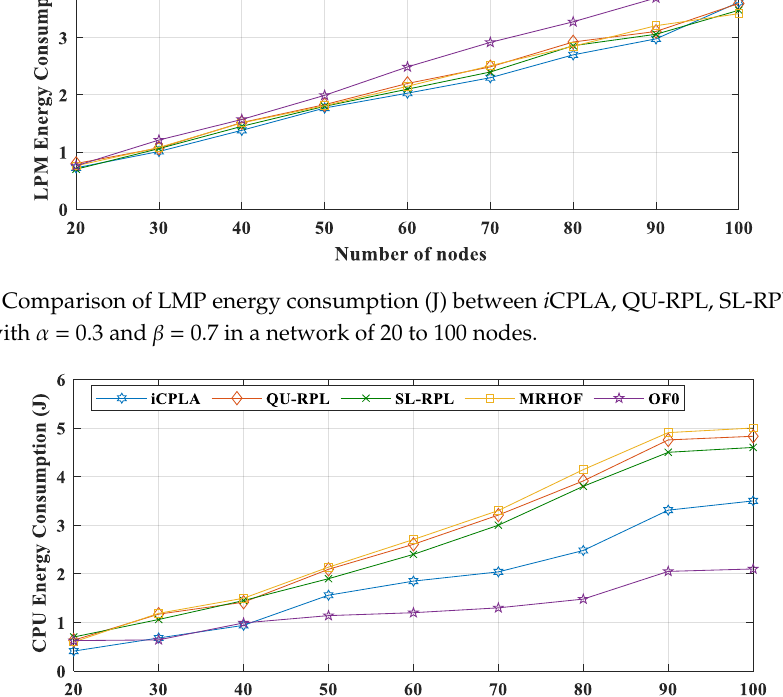
Figure 14. Comparison of average Tx energy consumption (J) between i CPLA, QU-RPL, SL-RPL, MRHOF, and OF0 with 𝛼 = 0.3 and 𝛽 = 0.7 in a network of 20 to 100 nodes.